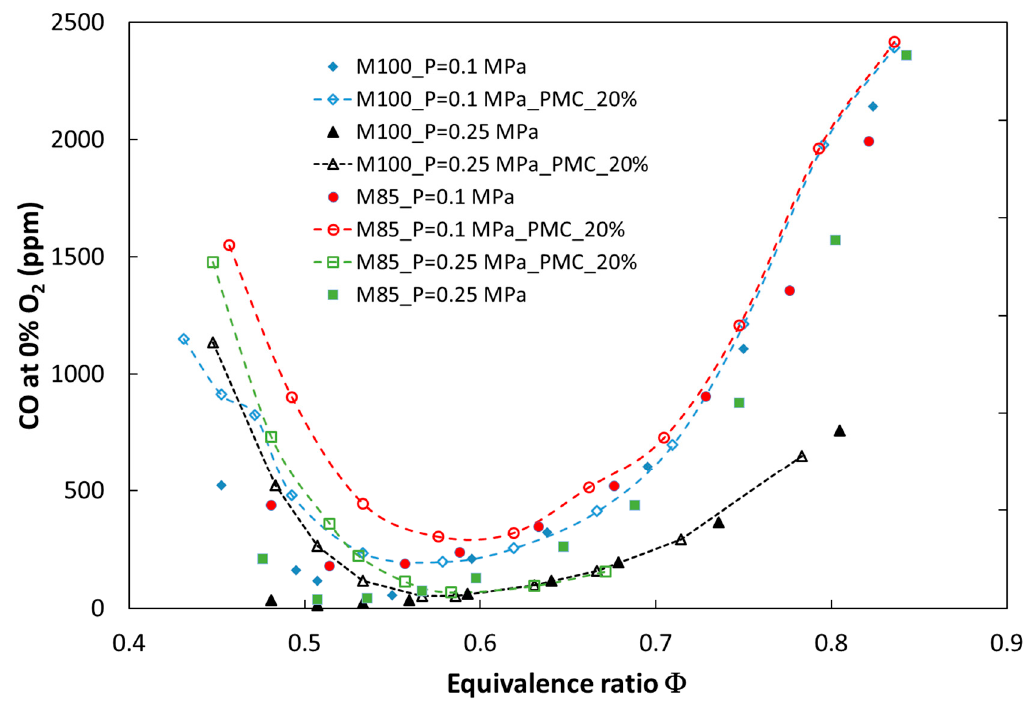
Figure 10. Experimental CO emissions for tested fuels in various configurations of the combustion process versus equivalence ratio.